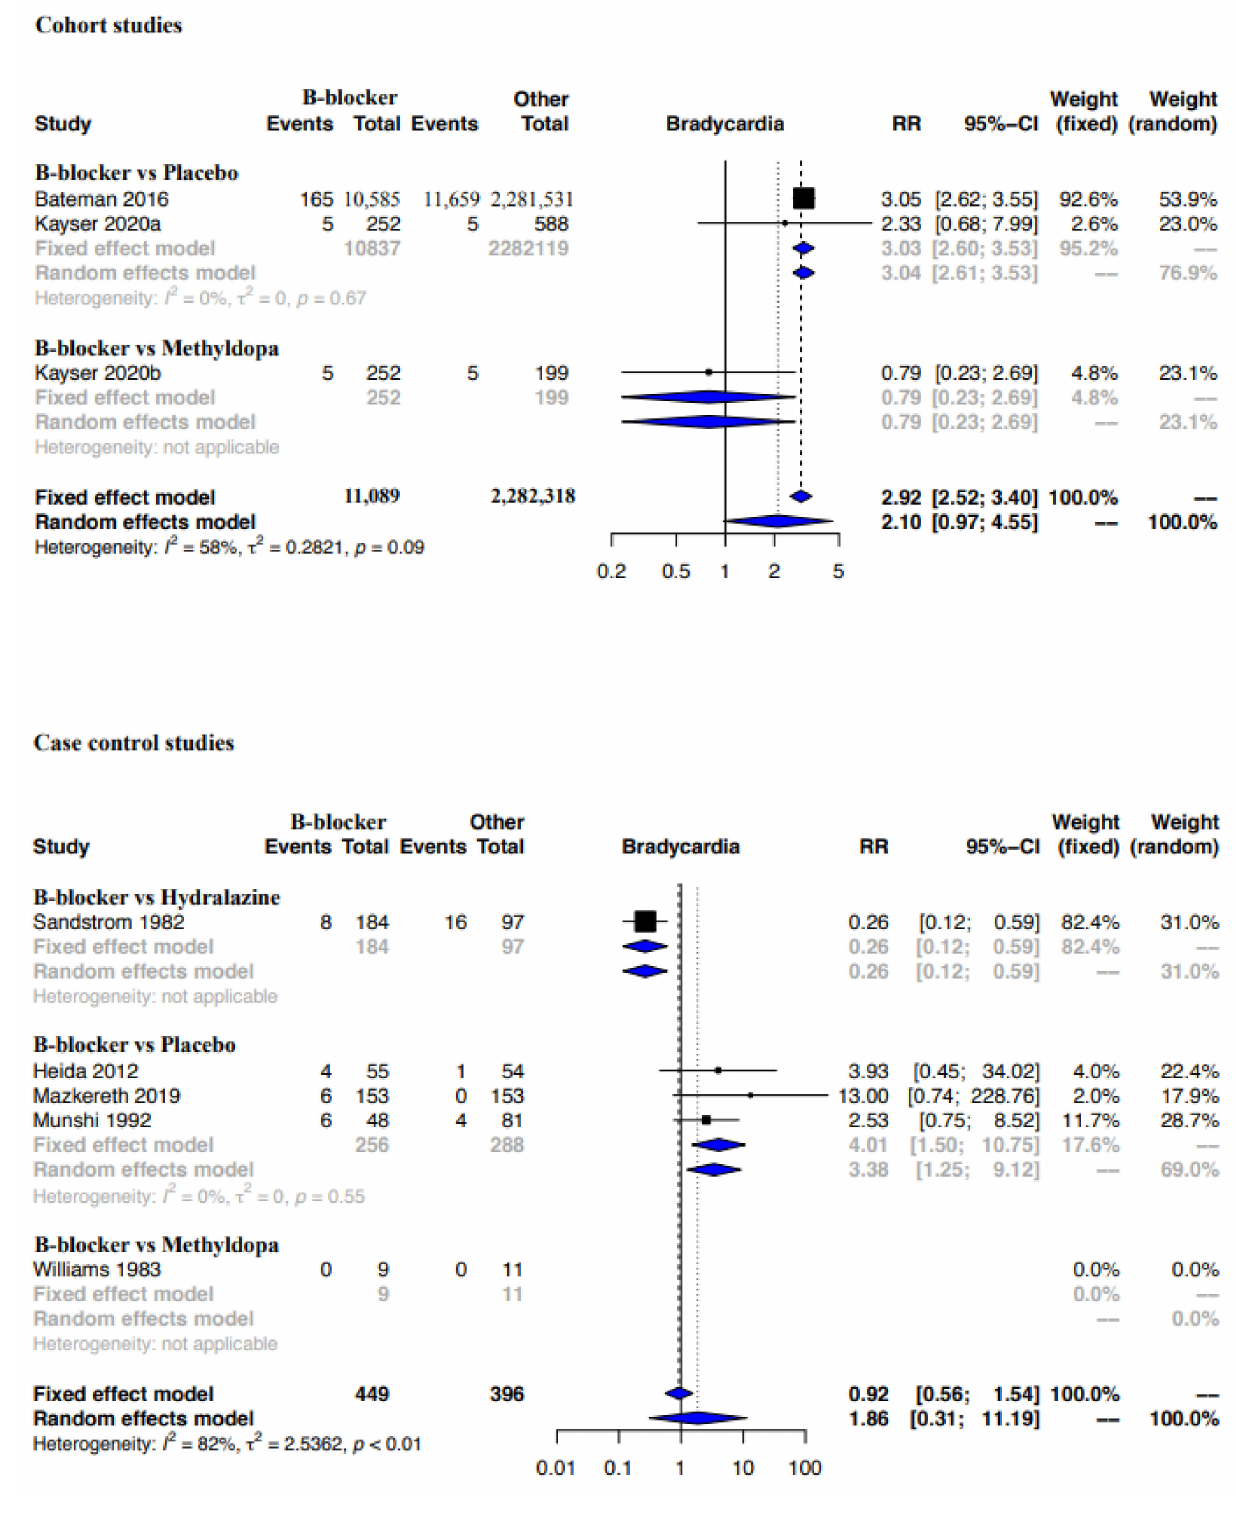
Figure 4. Meta-analysis bradycardia—Cohort and case–control studies. Cohort studies: beta-blocker vs. placebo: [30,35]; beta-blocker vs. methyldopa: [30]. Case control studies: beta-blocker vs. hydralazine: [58]; beta-blocker vs. placebo: [32,37,43]; beta-blocker vs. methyldopa: